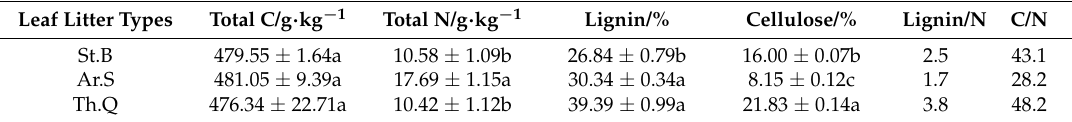
Table 1. The chemical properties of tested leaf litters. Table 1 The chemical properties of tested leaf litters.